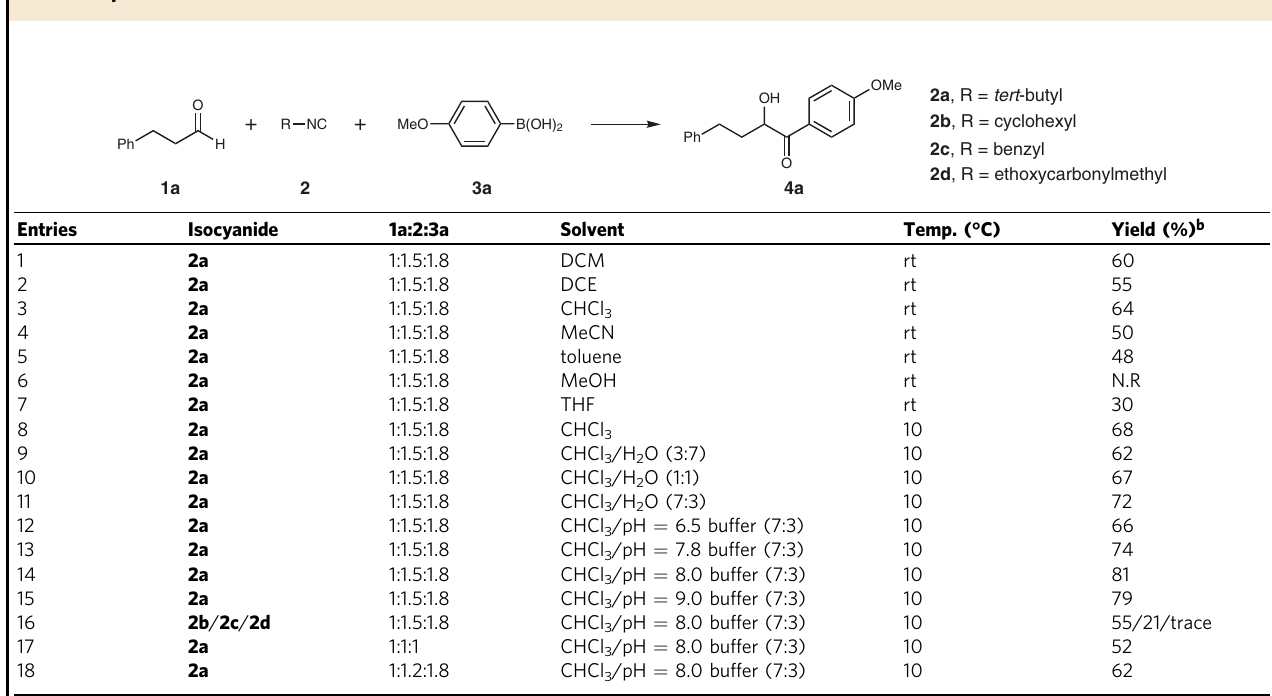
Table 1 Optimization of the reaction conditions a